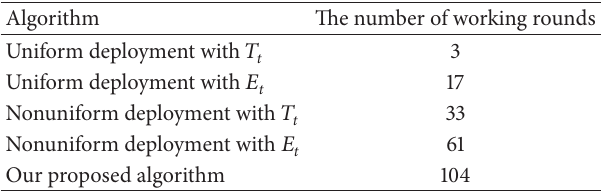
Table 1: Comparison of the number of working